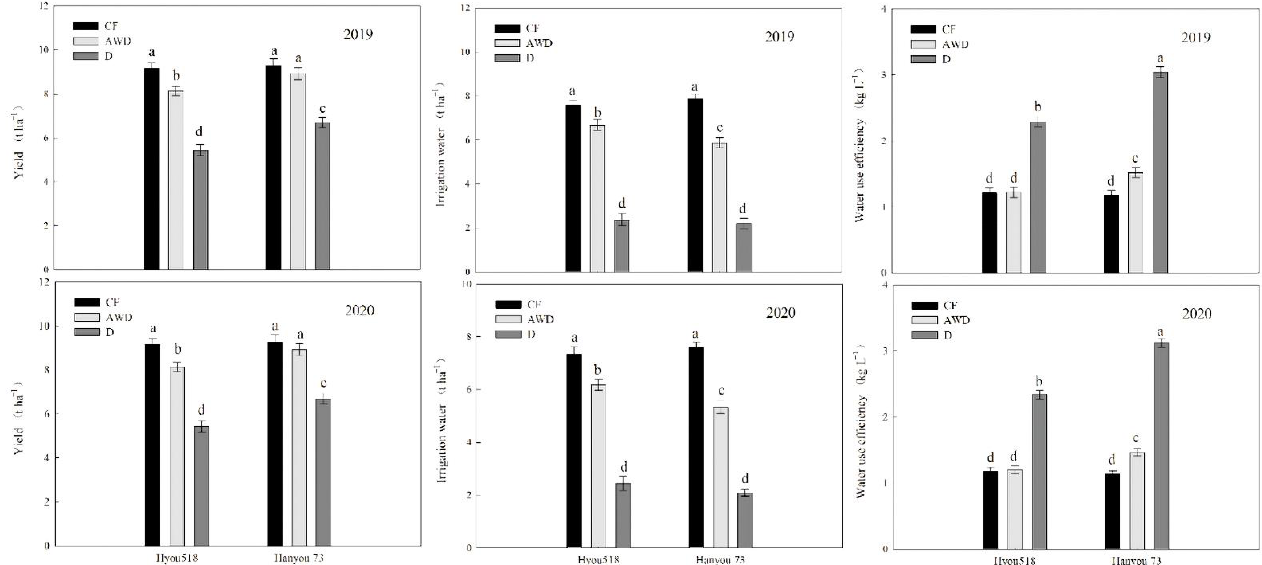
Figure 1. Grain yield, irrigation water, and water-use efficiency under various irrigation treatments. CF, AWD, and D represent continuously flooded, alternate wetting and moderate soil drying irri- gation, and dry cultivation, respectively. Vertical bars represent the ± standard errors of the mean ( n = 3) where these exceed the size of the symbol. Different letters above the column indicate statis- tical significance at the p = 0.05 level within the same variety. Water use efficiency: grain yield (kg)/(amount of irrigation water + precipitation) (m 3 ).